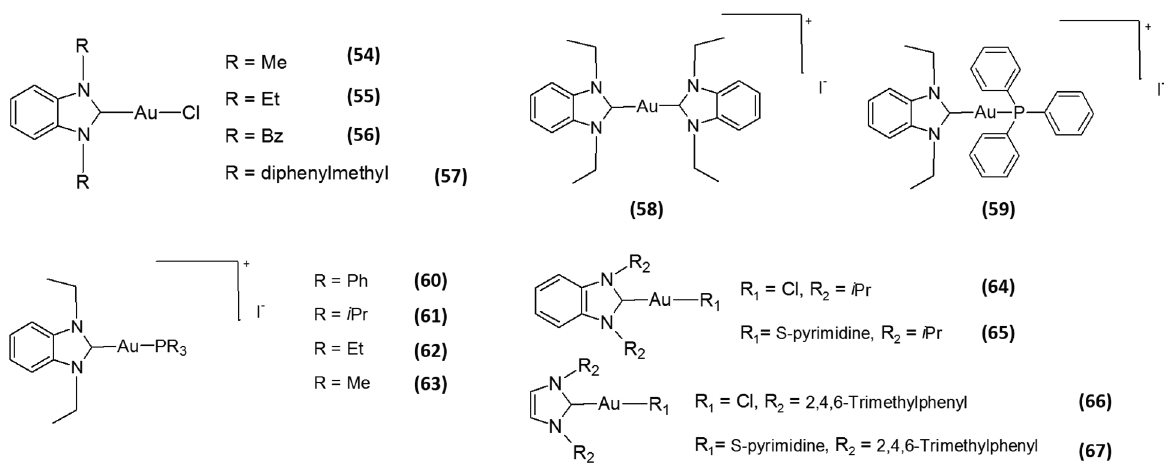
Figure 3. Structures of N -heterocyclic carbene (NHC) gold(I)-based